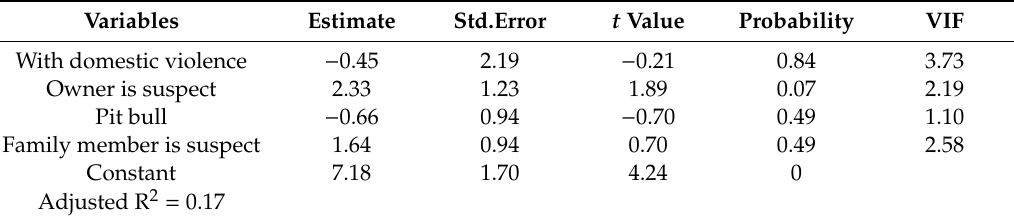
Table 2. Regression of human relationships / circumstances surrounding cruelty. (A number of variables were removed from the equation due to high VIFs including: location of cruelty; breed of dog other than pit bull designation; abuse caused by police, unknown persons, in the course of a break-in, and neighbors; whether there was a history of abuse or bites for the animal involved; type of animal involved; specific nature of the cruelty; and number of animals involved. Reference categories thus include cruelty not part of domestic violence, cruelty by neighbor, and other dog